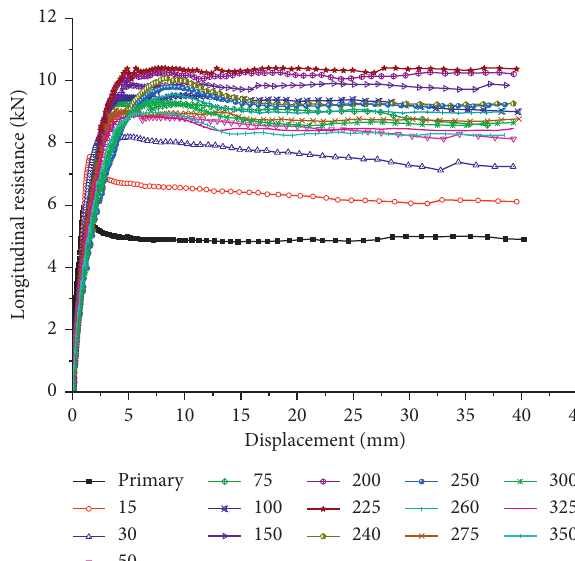
Figure 4: Relationship between the longitudinal resistance of the fastener and its displacement under different loading